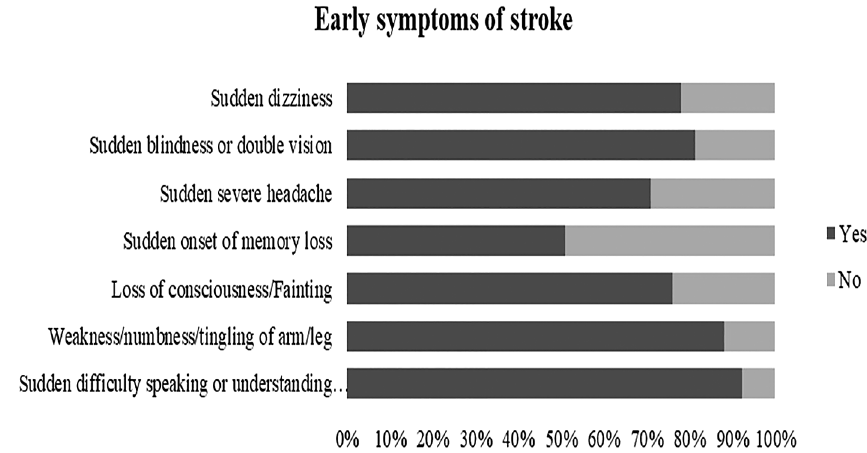
Figure 3. Awareness of stroke early